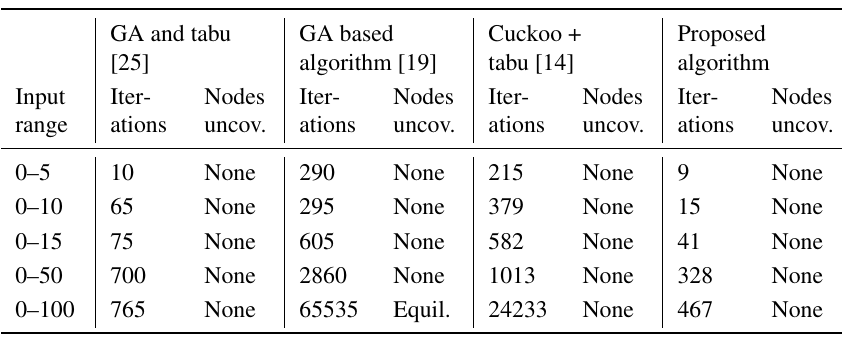
Table 6. Comparisons with other similar